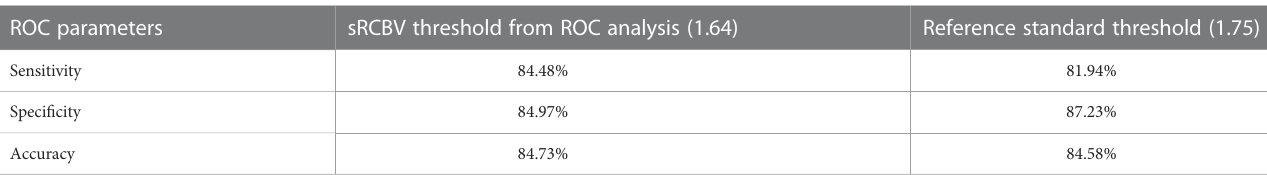
TABLE 1 Comparison of sensitivity, speci fi city and accuracy between the sRCBV threshold generated from ROC analysis (1.64) and the reference standard threshold (1.75) across 23 subjects. ROC parameters sRCBV threshold from ROC analysis